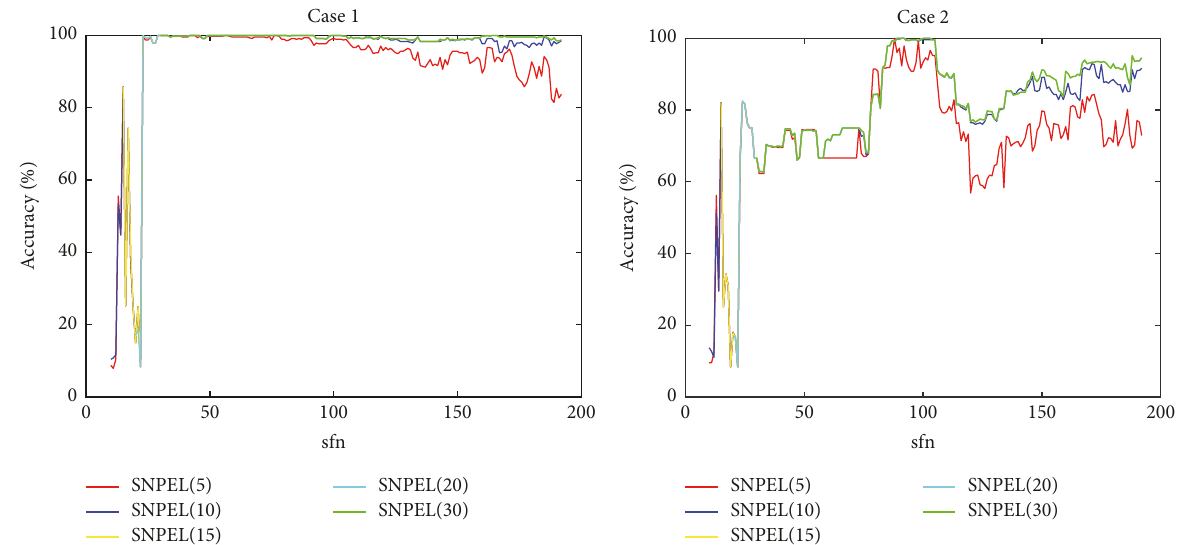
Figure 18: The diagnosis results obtained by OFS-FSASD-SNPEL-SVM using MODWPT with different dimension sizes for SNPEL. The SNPEL (5) represents that the number of dimension sizes is